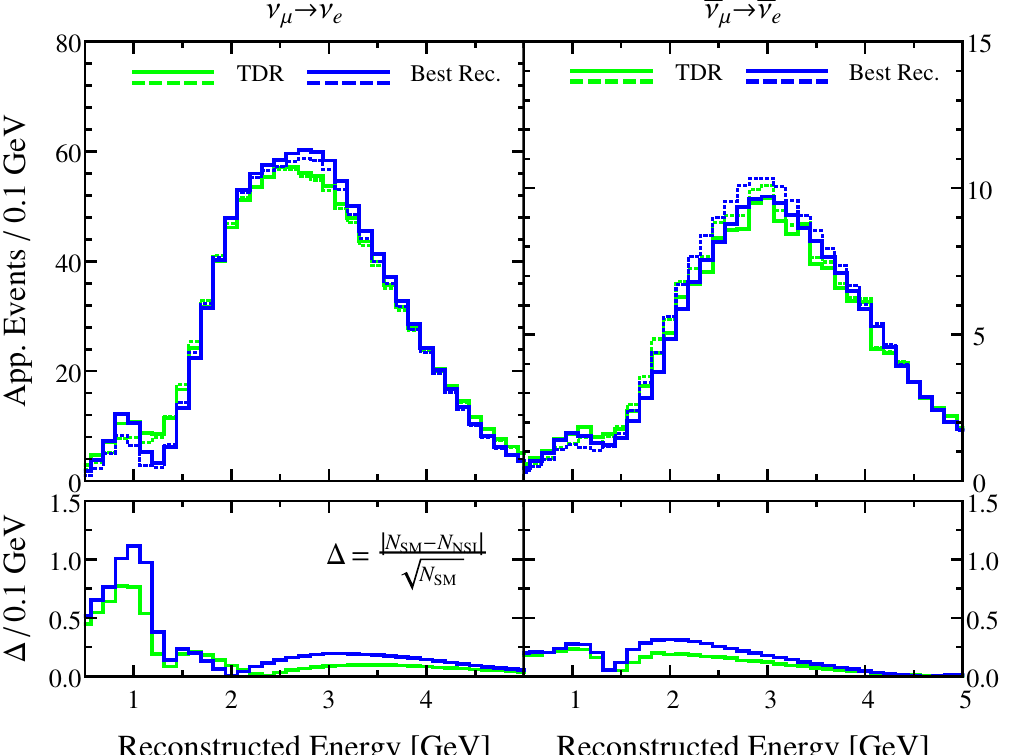
Figure 10 . Upper left (right) panel presents the ν µ → ν e ( ¯ ν µ → ¯ ν e ) appearance event spectra as a function of reconstructed energy. Green and blue lines correspond to the TDR and Best Reconstruction configurations respectively. Solid lines represent the standard three-neutrino spectra with δ CP = − 90 ◦ and dashed lines represent the spectra with NSIs in the e − e and e − τ sectors simultaneously. In case of NSI, we have taken the best fit parameters corresponding to the black star in the upper left panel of figure 7, i.e., δ CP = − 22 ◦ , ε ee = 2 . 70 , | ε eτ | = 0 . 65 , and φ eτ = − 177 ◦ for the TDR, and δ CP = − 23 ◦ , ε ee = 2 . 70 , | ε eτ | = 0 . 65 , and φ eτ = − 170 ◦ for the Best Reconstruction case. The best fit values of θ 13 , θ 23 , and ∆ m 2 have also been chosen from the simulation for both 31 the standard and the NSI scenarios. Lower left (right) panel represents the absolute difference in the upper left (right) appearance events between the standard and the NSI scenarios divided by the statistical uncertainty in each bin. The color coding is the same as in the upper